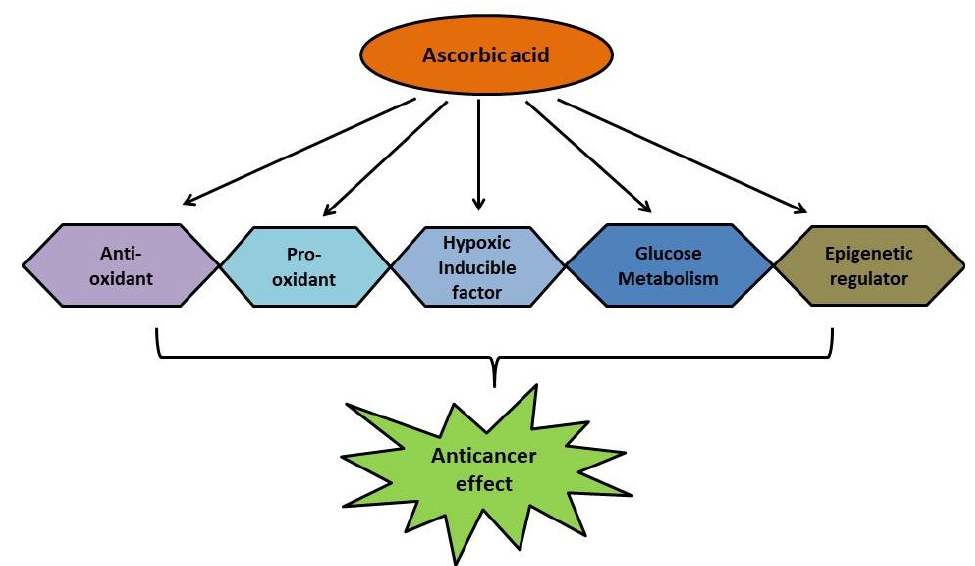
Figure 5. The different mechanisms involved in the interventions of ascorbic acid as an anticancer